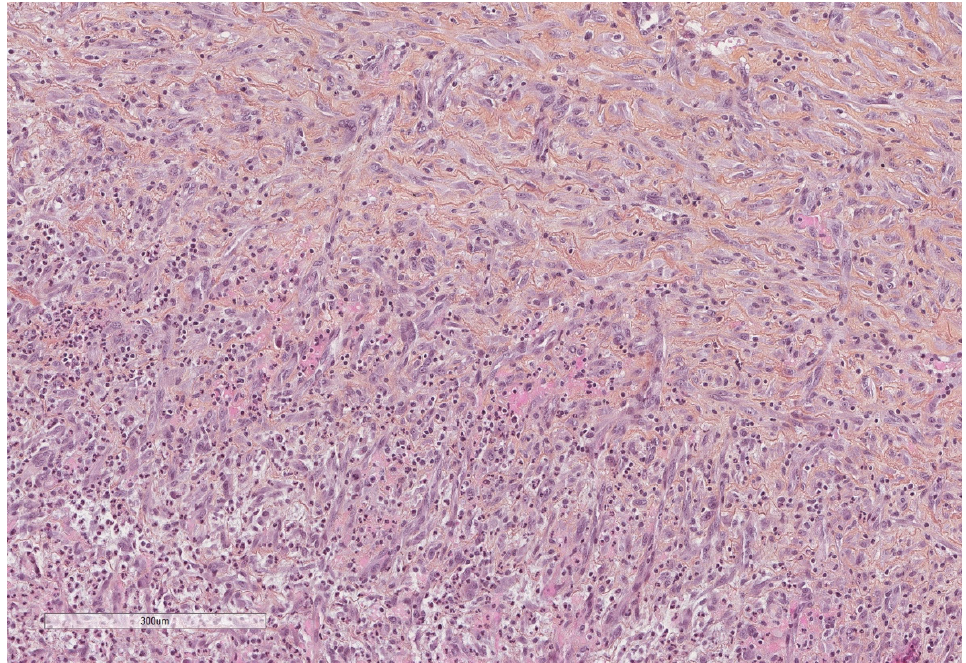
Figure 14. Neutrophils infiltrate and vascular proliferation seen towards the pleural cavity surface (lower part of the image), whereas dense collagenous tissue replaces this inflammation in the deepest parts of the pleura (upper part of the image). Hematoxylin, eosin, saffron staining (×400).